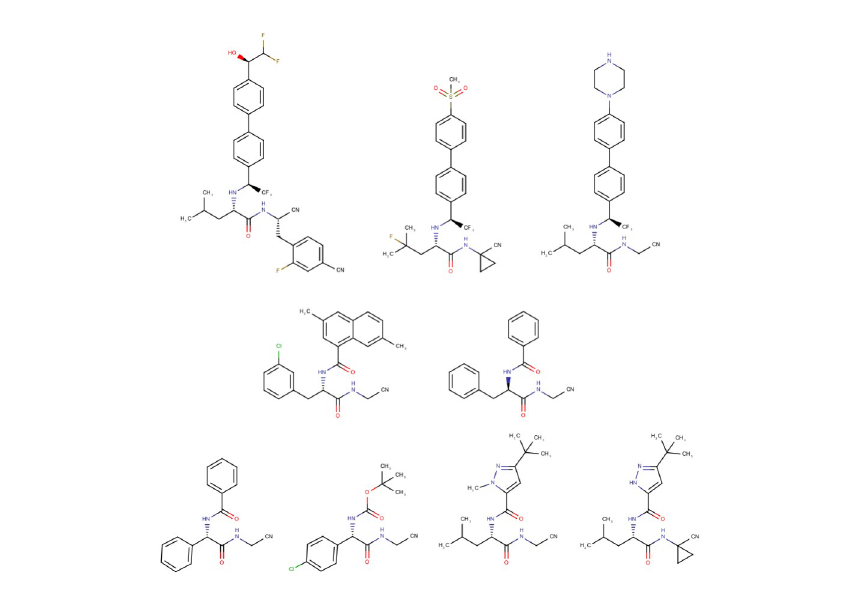
Fig 1. Structure of dipeptidyl nitriles used in this work. Top, left to right: ICR, ICK, ICL. Centre, left to right: IKR and BCR. Bottom, left to right: Neq0409, Neq0544, Neq0568, Neq0569.